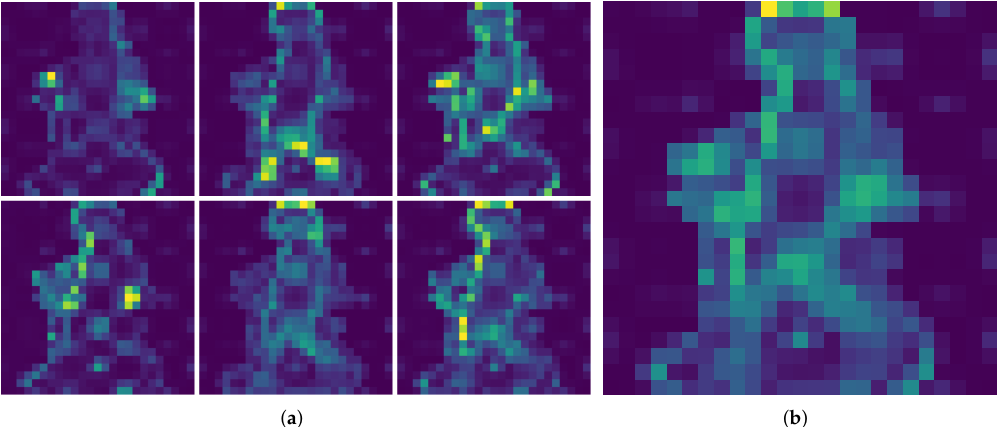
Figure 5. Self-attention of the CLS token on random OU-MVLP sample image. ( a ) Self-attention heads. ( b ) Average of all self-attention